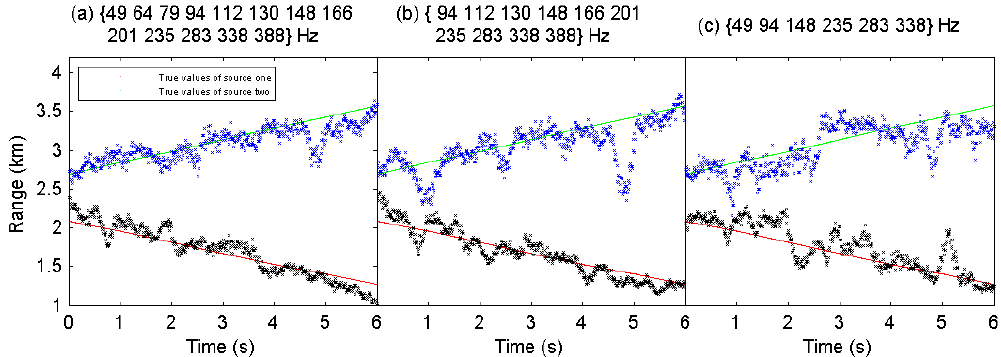
Figure 16. The source rang estimates across time using different frequency bins in the two-source scenario using the real experimental